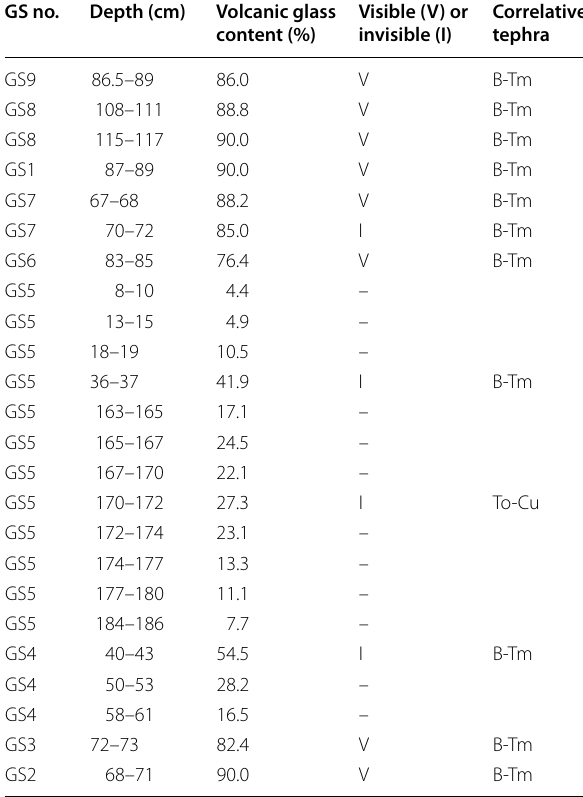
Table 3 Tephra-analysis samples GS